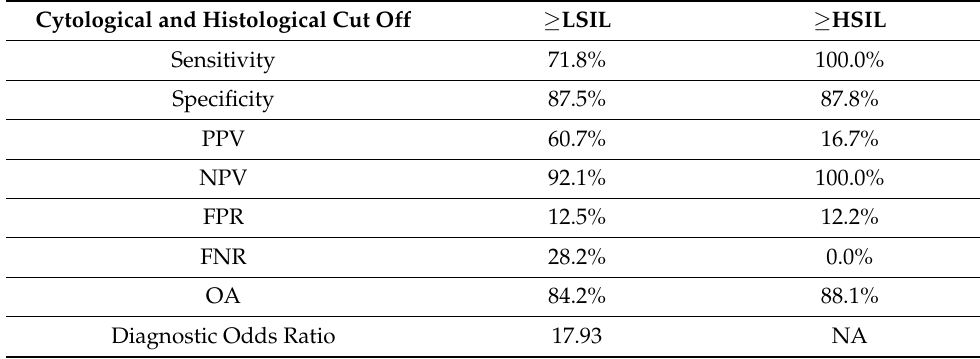
Table 3. Performance indicators of Papanicolaou test using as gold standard the histological outcome.